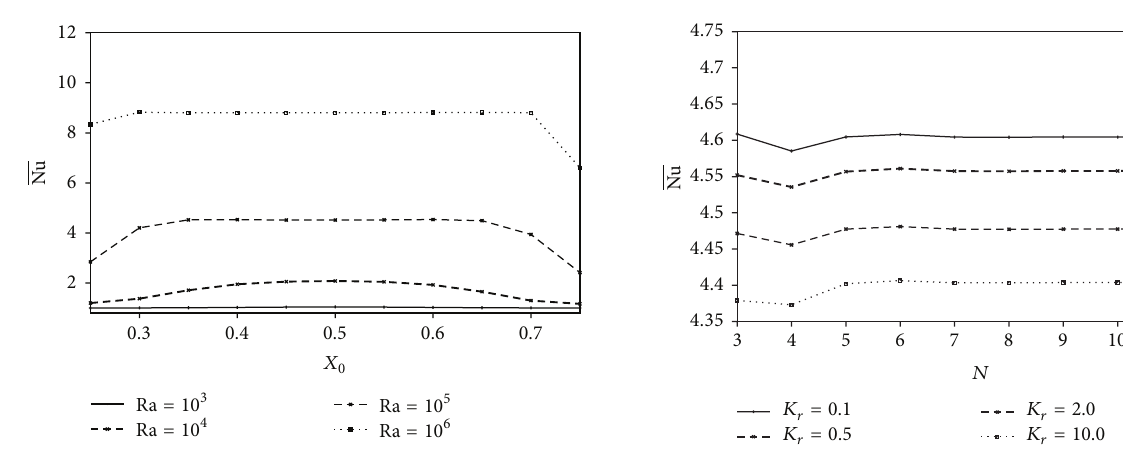
Figure 7: Variation of Nu with 𝑋 0 for different values of Ra at 𝐾 𝑟 = 1.0 and 𝐴 = 𝜋/25 .